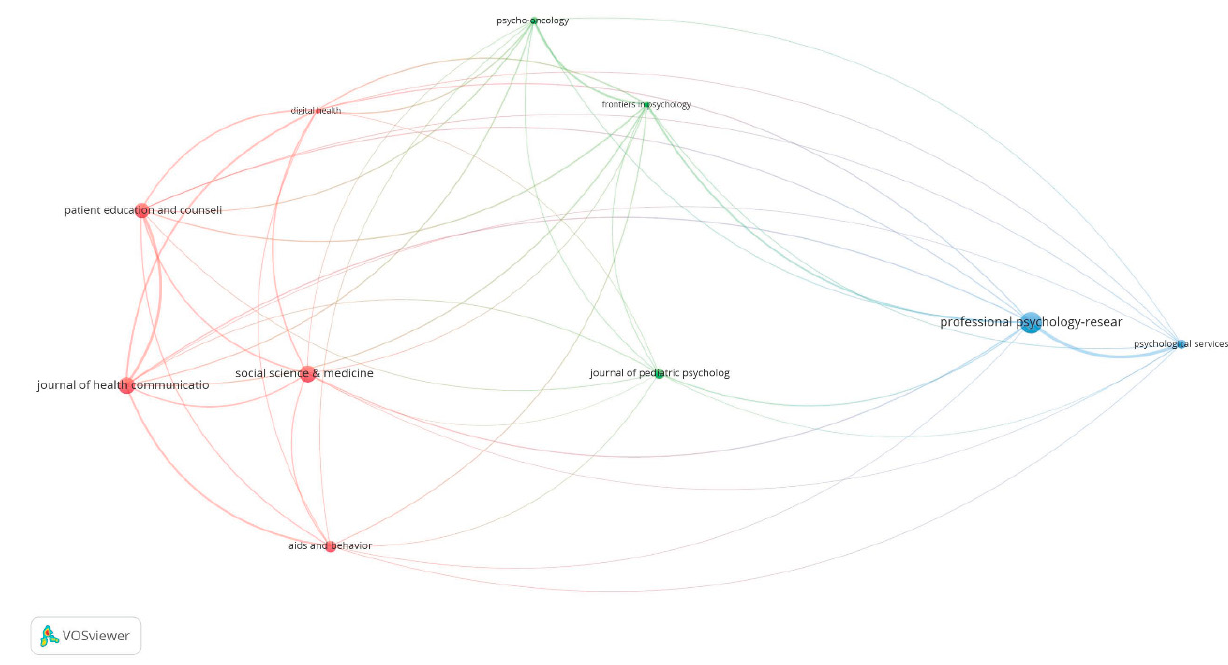
Figure 4. Cluster analysis of co-citations among the most relevant journals. Table 5. Articles with the largest number of citations on eHealth and social